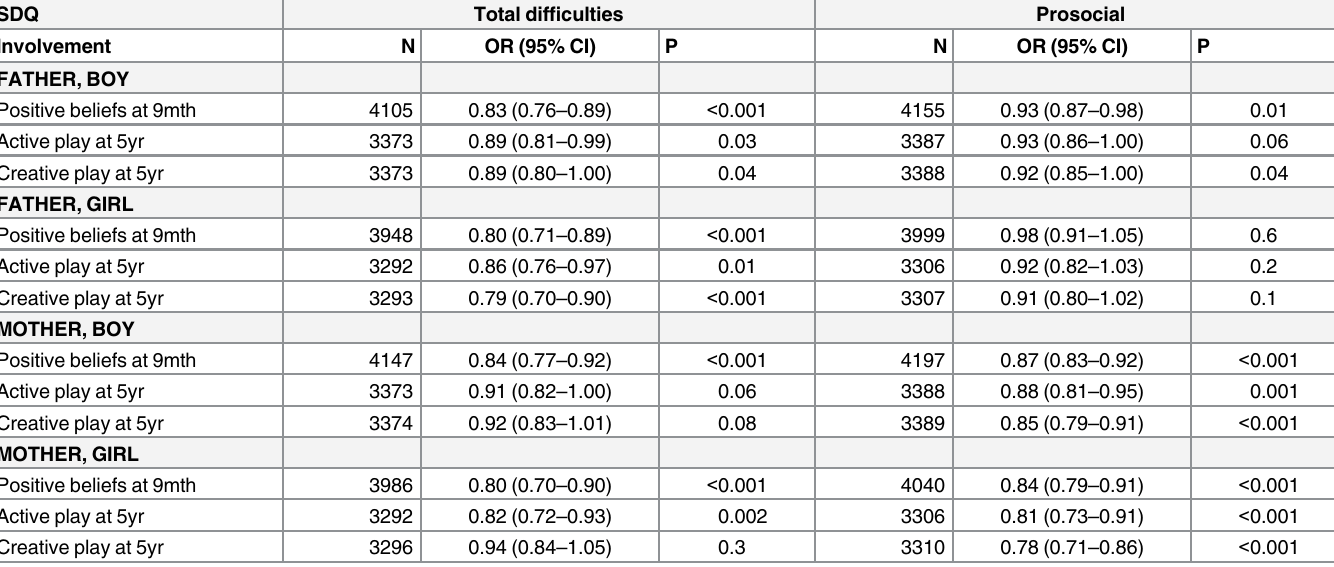
Table 6. Crude odds ratio for child behaviour problems per quintile of involvement: both-parent